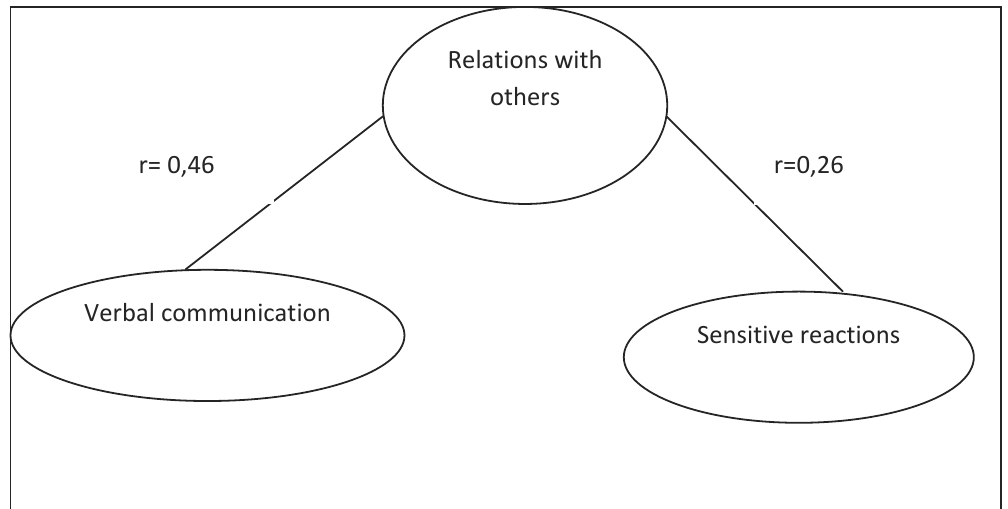
Fig. 2. Correlation coef (cid:222) cients between the indices of ASD